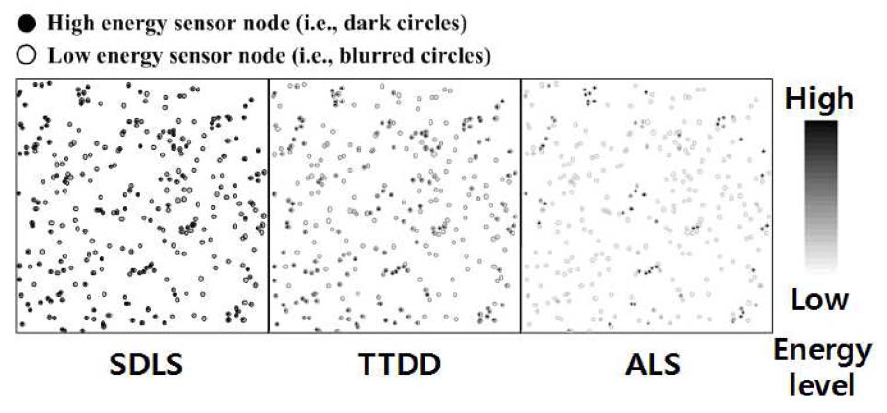
Figure 8. Remaining energy power of the sensor nodes for data communication.